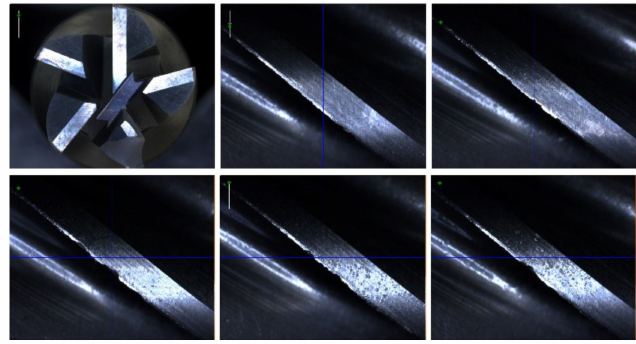
Figure 28. Tool wear for variable F